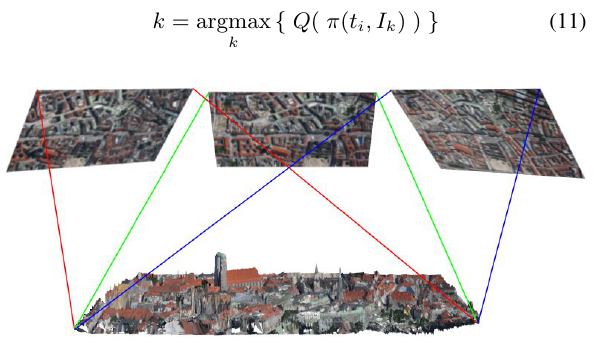
Figure 5: Multi-view